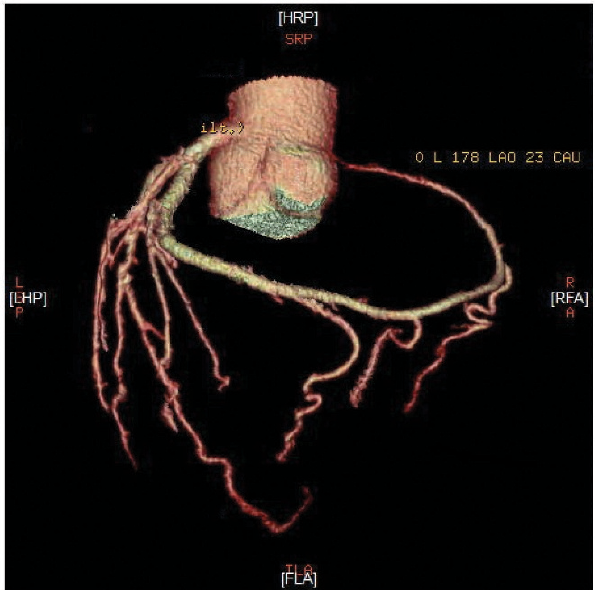
groove. The vessel terminated near the right sinus of Valsalva (Figure 2). Right coronary arteriography could not be performed because the right coronary ostium was not present, which was also confirmed by aortography (Figure 3). The patient underwent mitral valve surgery, and during surgery, the right coronary artery ostium was not observed (Figure